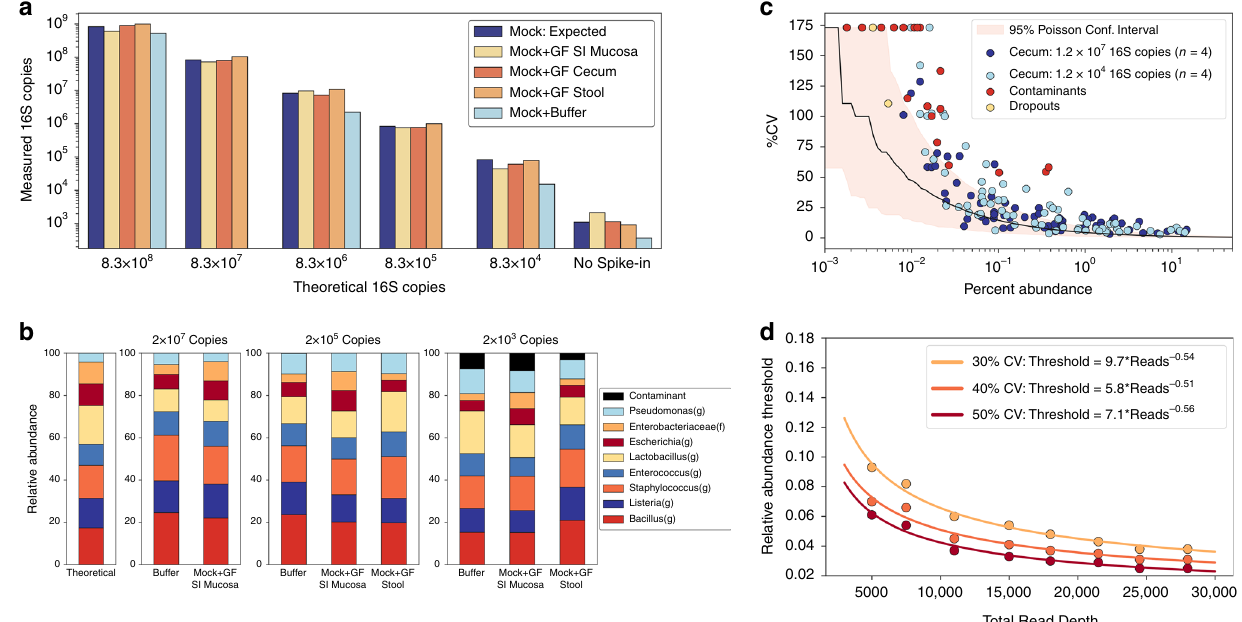
Fig. 2 Lower limits of quanti fi cation for total microbial DNA extraction and 16S rRNA gene amplicon sequencing. a A comparison of theoretical and measured copies of the 16S rRNA gene with digital PCR using an eight-member microbial community spiked at a range of dilutions into germ-free (GF) mouse tissue from small-intestine (SI) mucosa, cecum contents, and stool. Each bar plot shows a single technical replicate for each matrix. b Relative abundance of the eight taxa as predicted and measured after 16S rRNA gene amplicon sequencing. c Correlation between the mean ( n = 4) relative abundance of each taxon and the coef fi cient of variation (%CV) using a cecum sample from a mouse on a chow diet with an initial template input of either 1.2 × 10 7 or 1.2 × 10 4 16S rRNA gene copies. Each analysis comprised four technical (sequencing) replicates. Taxa found only in the low-input sample were labeled contaminants (red points); taxa found in the high-input sample but not low-input sample were labeled dropouts (yellow points). Red shading indicates the Poisson sampling 95% con fi dence interval (10,000 bootstrapped replicates) at a sequencing read depth of 28,000. d Relationship between relative abundance threshold (see text for details) and sequencing read depths at 30%, 40%, and 50% CV